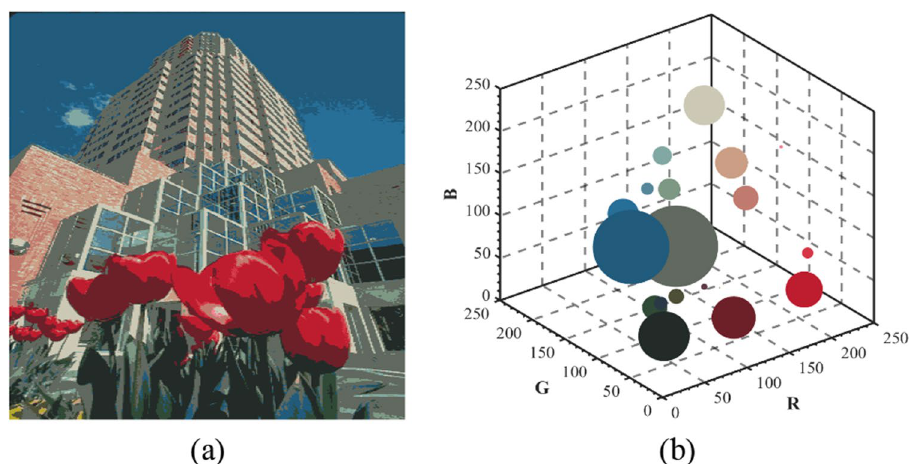
Fig. 4 a Quantized image: t = 2, s = 27, m = 21. b Color distribu- tion of